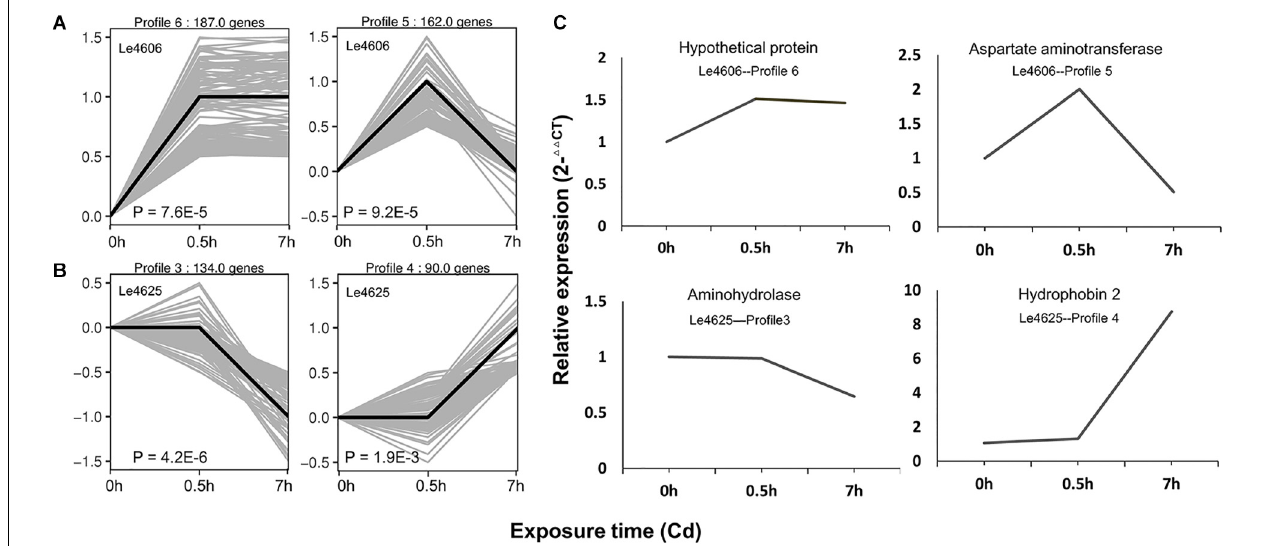
FIGURE 2 | Expression patterns of DEGs and the qRT-PCR validation. (A) Significant expression patterns of DEGs in Le4606. (B) Significant expression patterns of DEGs in Le4625. (C) qRT-PCR validation of DEGs in Le4606 (patterns 5 and 6) and 4605 (patterns 3 and